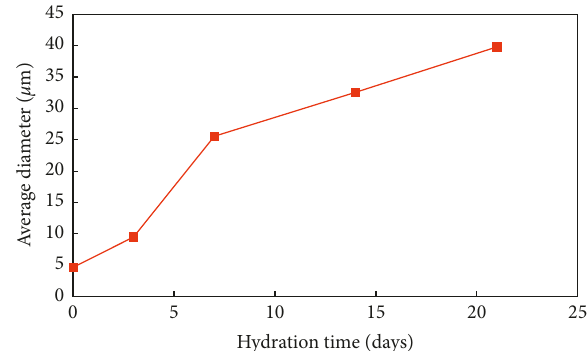
Figure 4: Average diameter of polymeric microsphere versus hydration